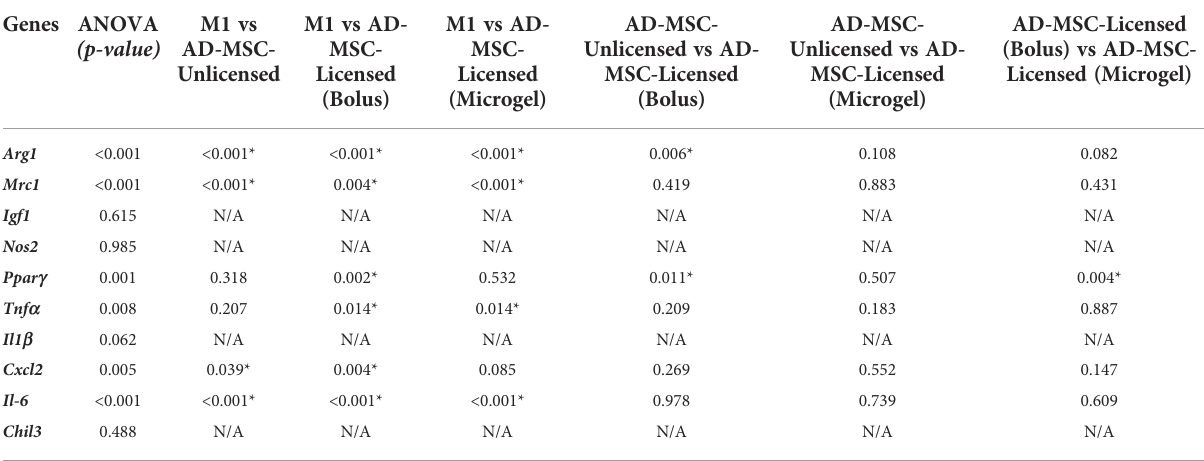
TABLE 6 Pairwise comparison between all treatment conditions. Holm-Sidak Pairwise Comparison (Between Groups) (p-value) Genes